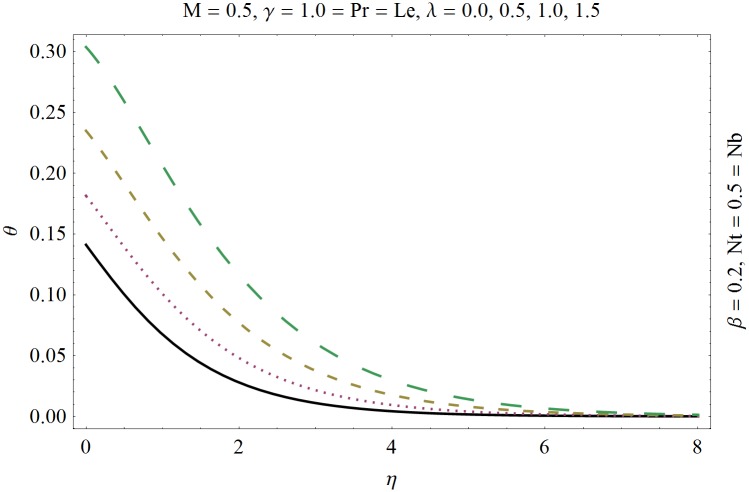
Influence of heat source (λ>0) on θ.